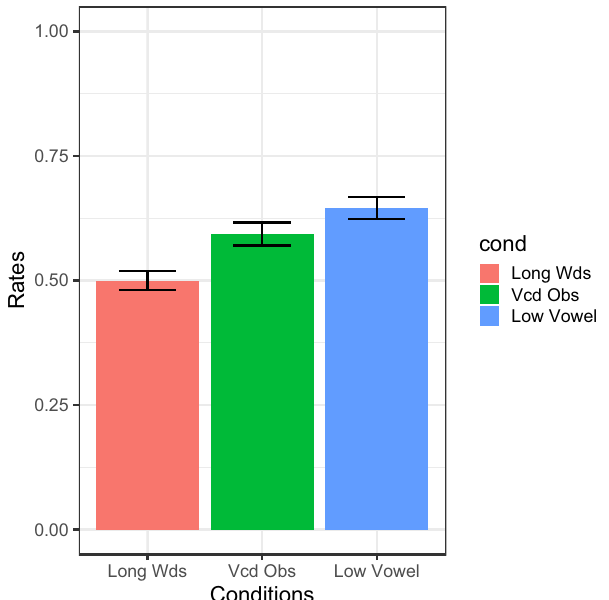
Figure 1: Rates at which the nonce words in the experimental groups were judged as powerful spells ( all participants; N = 115 ) .